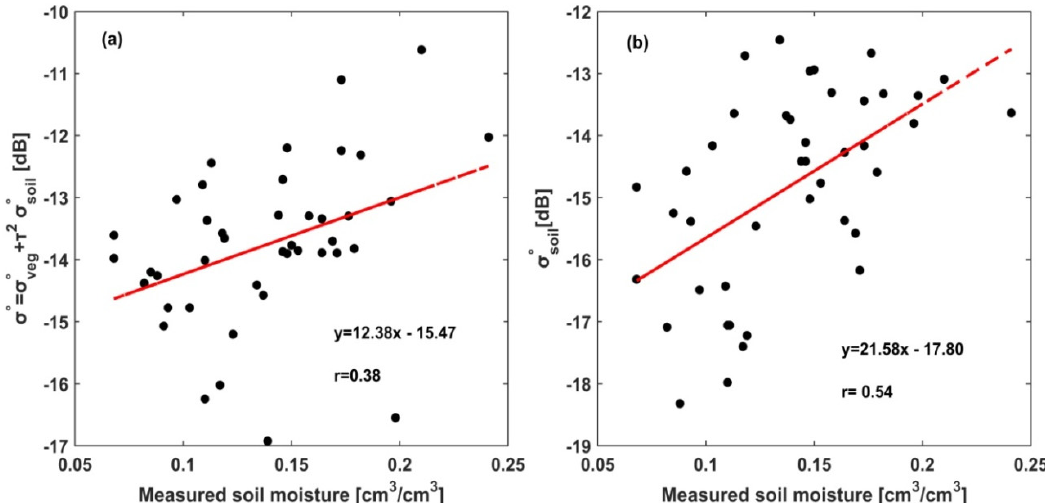
Figure 6. The correlation between ( a ) field-measured soil moisture (at 5 cm depths) and Sentinel-1 radar backscatter ( 𝜎 ° ) and ( b ) the correlation between field-measured soil moisture and soil backscatter signals ( 𝜎 (cid:3046)(cid:3042)(cid:3036)(cid:3039)° ) . The red lines show the linear regression.